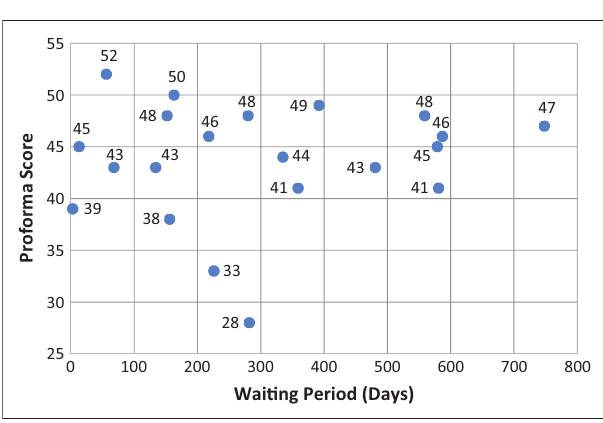
FIGURE 2: Scatter plot of waiting period and pro forma score of patients that received a corneal graft, eThekwini Health District,